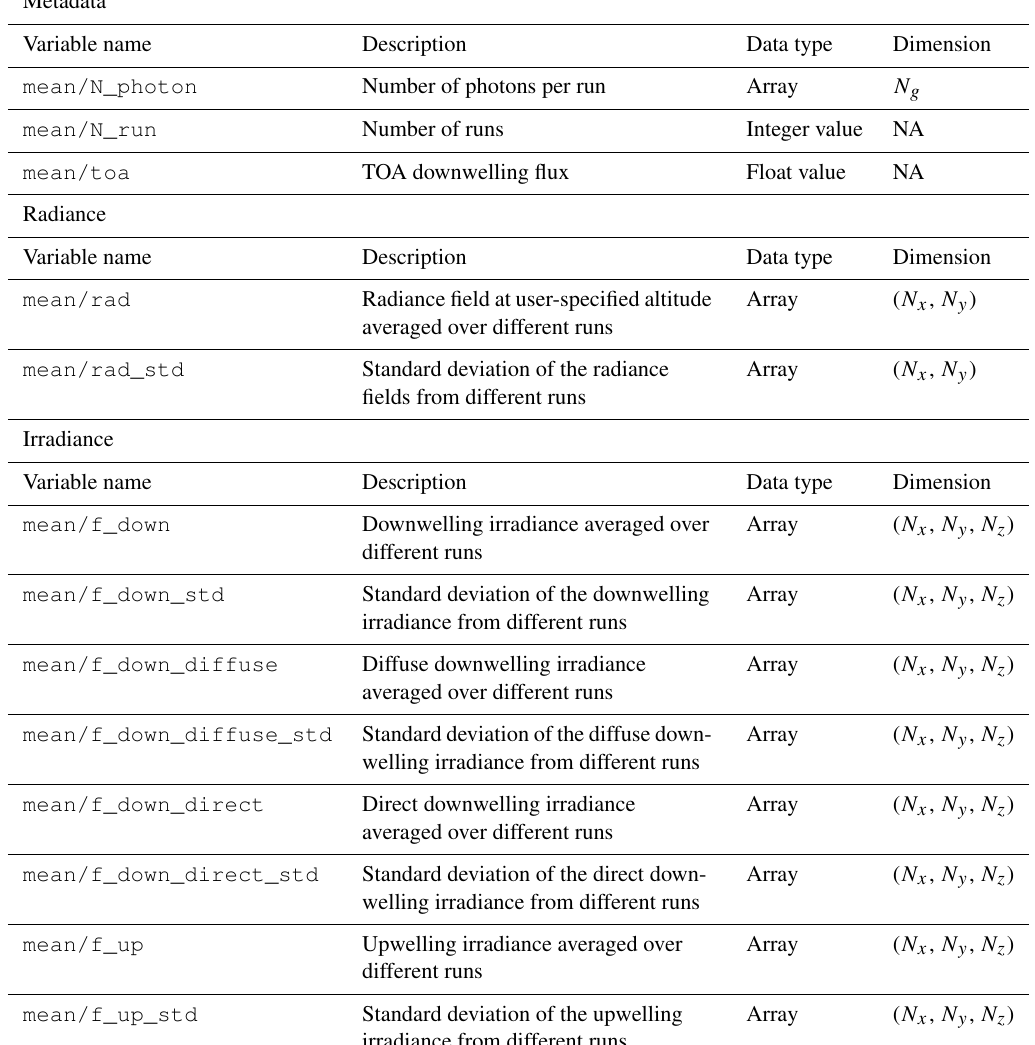
Table A2. Data variables contained in the output HDF5 file from EaR 3 T for radiance and irradiance calculations. The radiance is simulated with a user-specified sensor geometry at a given altitude using forward photon tracing. The data variables listed under “metadata” are included for both radiance and irradiance calculations. N x , N y , and N z are the number of pixels along x , y , and z direction, respectively. N g is the number of g , as explained in Appendix A2. NA: not